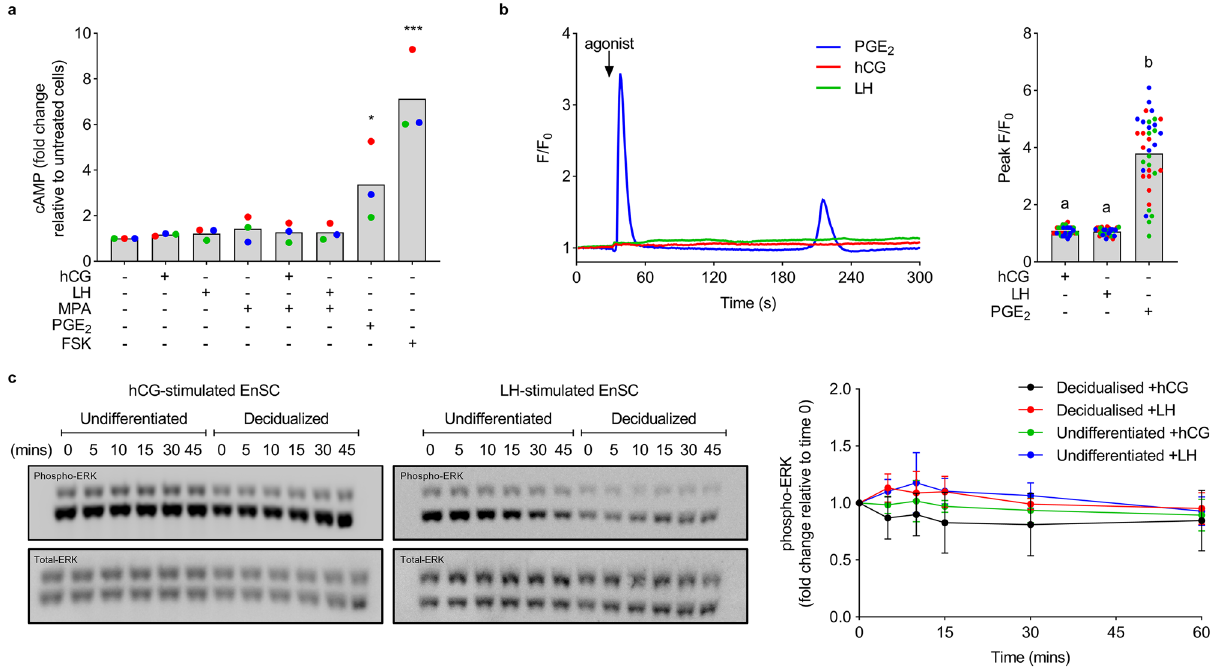
Figure 3. Lack of LHCGR signalling in EnSC. ( a ) The relative change in cAMP following 5-min stimulation with 10 nM hCG or LH (with or without MPA), 2 µM PGE 2 or 5 µM forskolin (FSK). Data are shown from 3 independent primary cultures, with bars denoting mean values. Significance was determined by ANOVA and Dunnett’s multiple comparison test using unstimulated cells as the comparator. * P < 0.05 and *** P < 0.001. ( b ) Representative Ca 2+ traces from EnSC challenged with 1 µM hCG or LH, or 2 µM PGE 2 (left panel). Data are shown as fold change in fluorescence relative to time 0 (F/F 0 ) and represent one individual cell. Mean peak responses of 36 cells from 3 independent cultures (denoted as separate colours) are shown in the right panel. Different letters indicate statistical differences ( P < 0.05) between groups (ANOVA and Tukey’s multiple comparison test). ( c ) Representative western blots showing levels of phospho-ERK in undifferentiated and decidualized EnSC following stimulation with either 10 nM hCG or LH (left panels). Levels of phospho-ERK were normalized to total-ERK and shown as fold change relative to unstimulated cells (time point 0) (right panel). Data are mean ± SD from 3 individual primary cultures. All changes from time 0 are non-significant (ANOVA and Dunnett’s multiple comparison